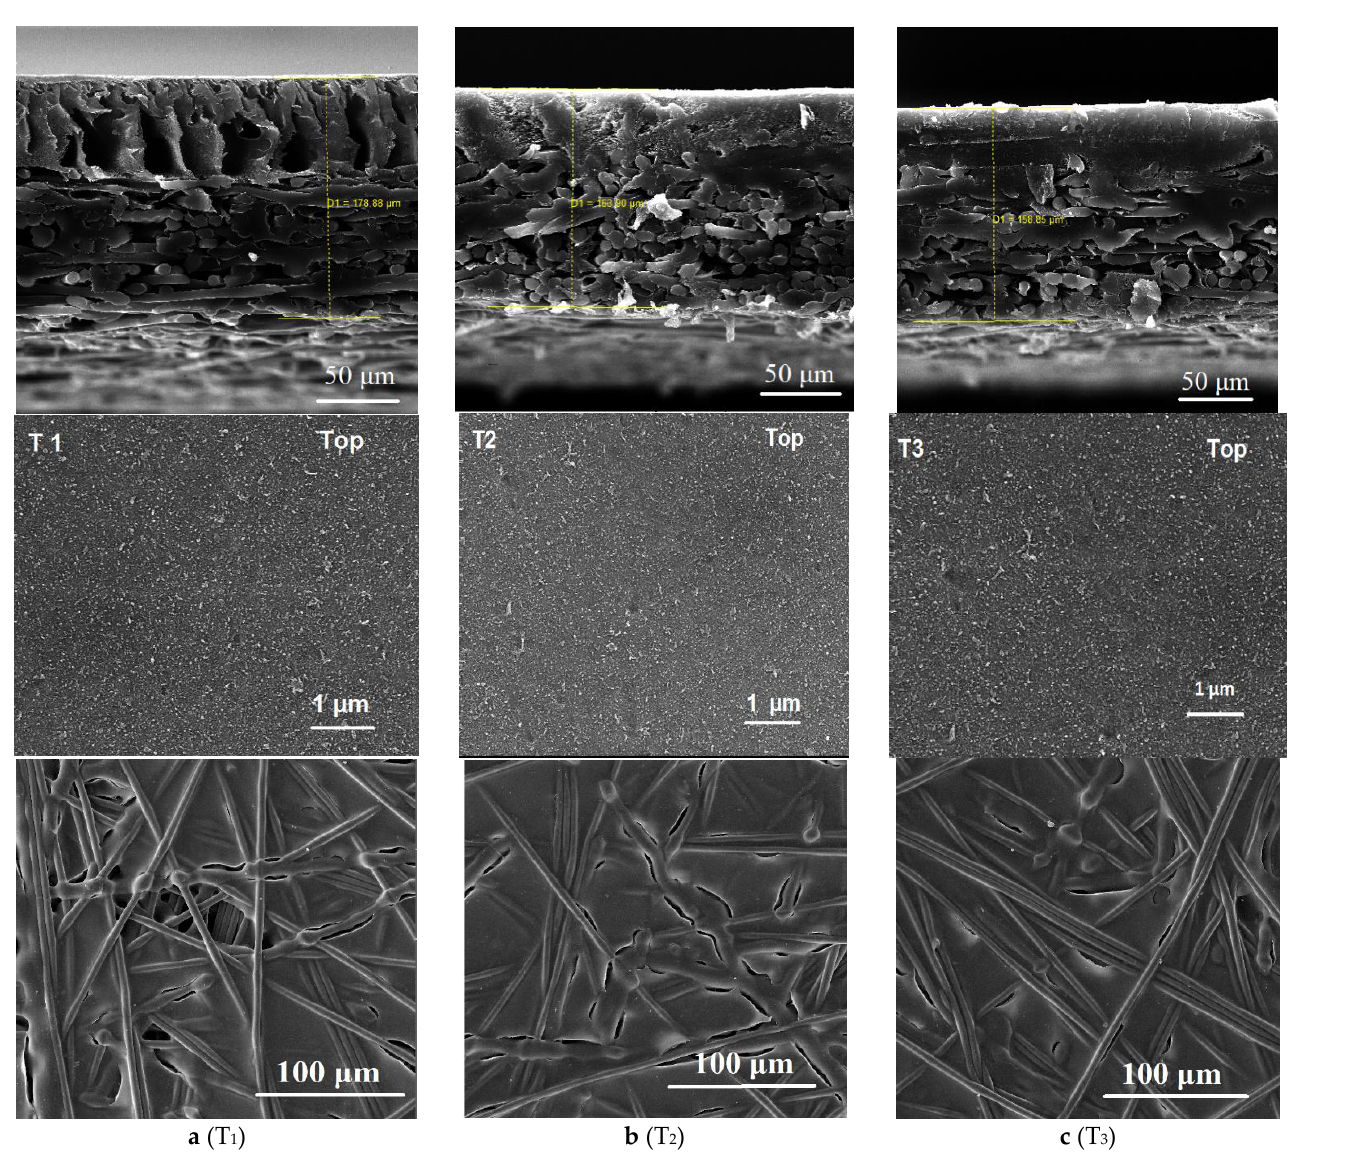
Figure 4. Scanning electron microscopy (SEM) images of cross-section, top surfaces, and bottom surfaces of the fabricated ( a ) PES (no sulfonated polymer), ( b ) SPES (25 wt % sulfonated material) and, ( c ) SPES (50 wt % sulfonated material) membrane substrate samples denoted as T 1 , T 2 , and T 3, respectively.